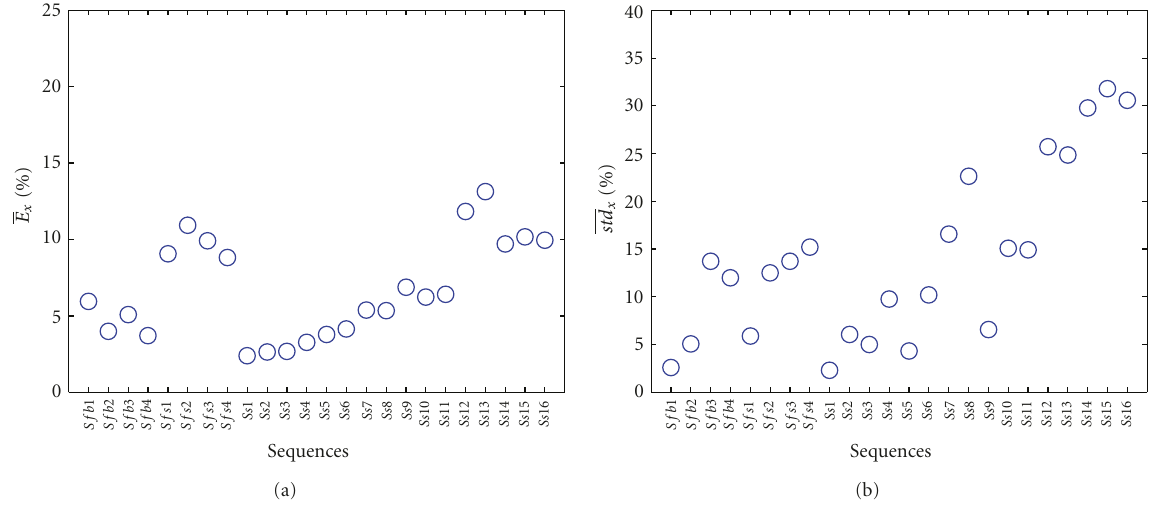
Figure 9: For each sequence, (a) normalized mean error E x , (b) normalized mean standard deviation std x .